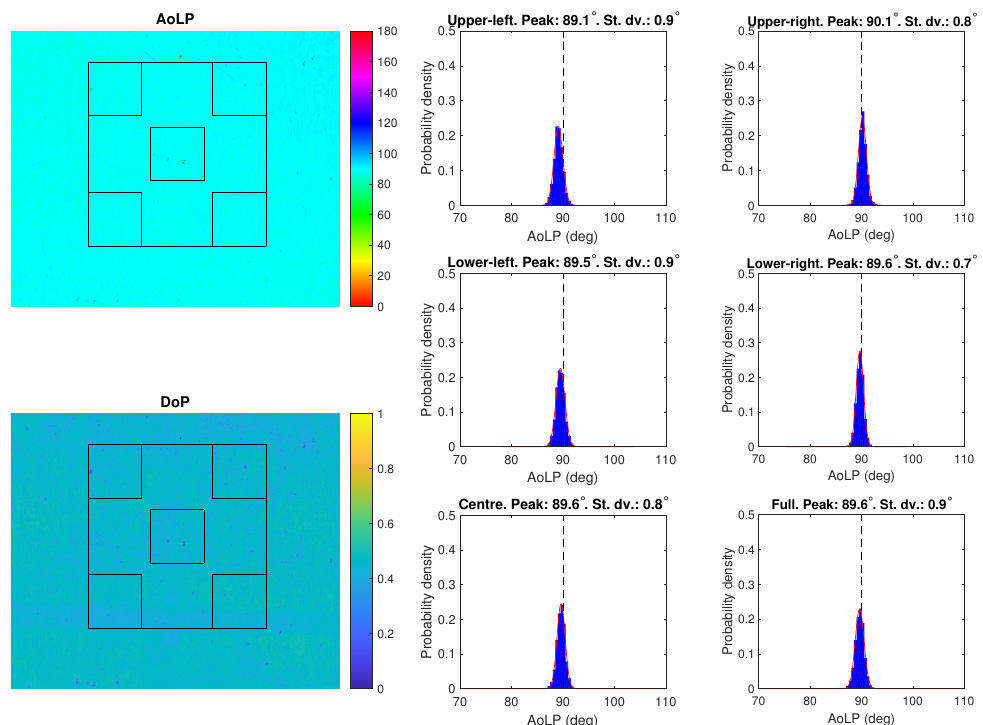
Figure 9. Results for the cured UD sample captured with dark field illumination. The left-hand images show the AoLP and DoP, where the scales indicate the values that the colours in the image represent. The spatial resolution is such that the width of the large ROI is approximately 10 cm. The graphs show AoLP histograms for each of the six ROIs highlighted in the images (including the larger “full” one). For each case, the Gaussian fit and corresponding means and standard deviations are indicated.